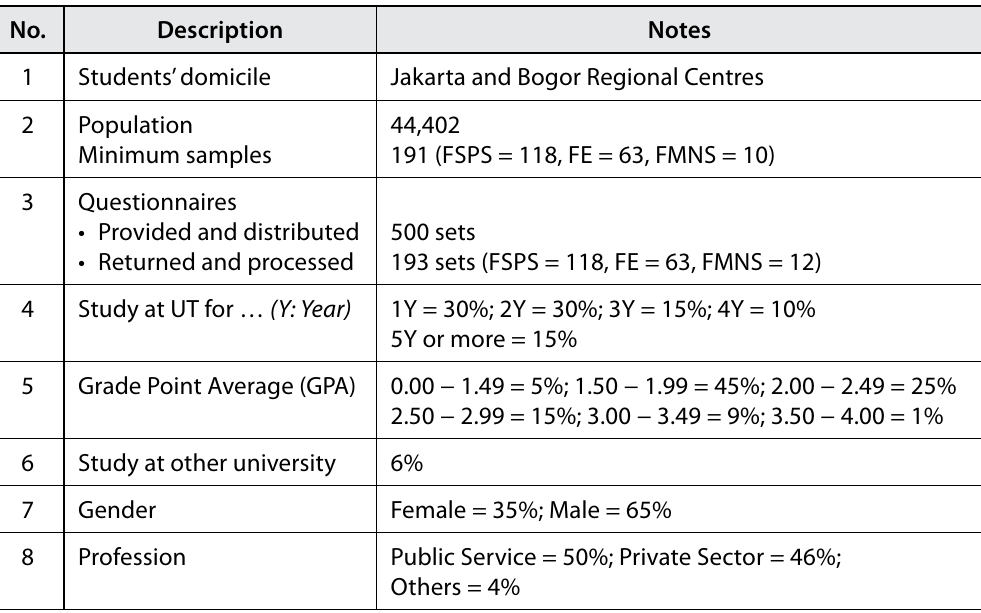
Table 3 Respondents’ characteristics, population, samples and questionnaires